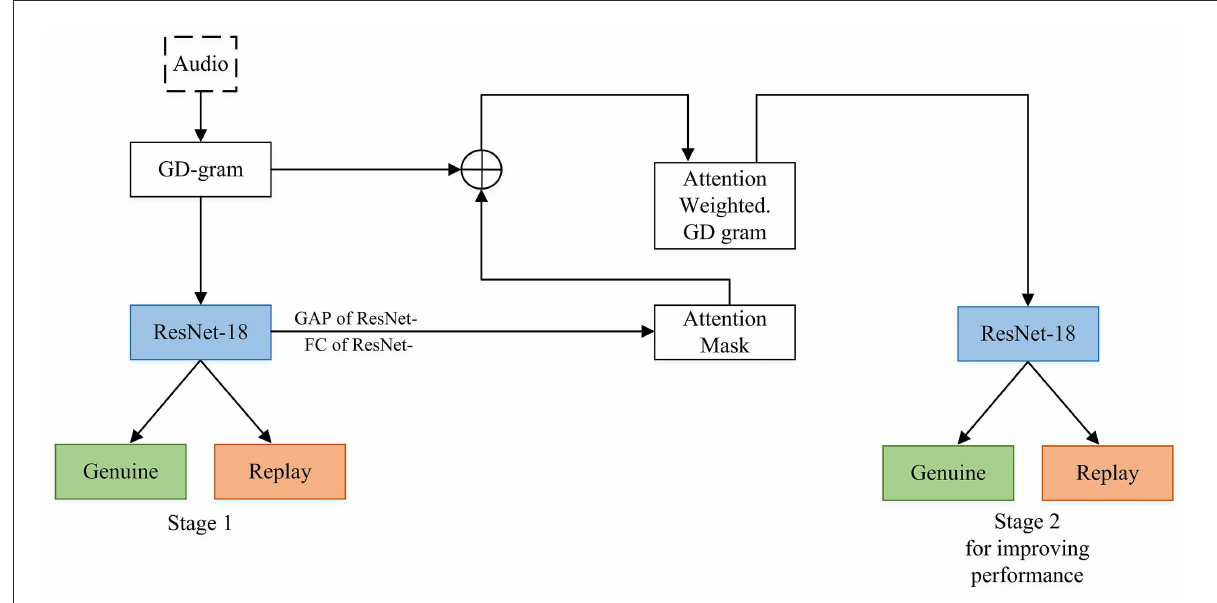
FIGURE3 Replay attack end-to-end detection. The audio input comes to group delay grams which are novel time-frequency representations of an utterance. Also, the novel attention mechanism softly weights the GD grams. The ResNet-18 network and its GAP layer are used to provide attention maps for a second stage of discriminative